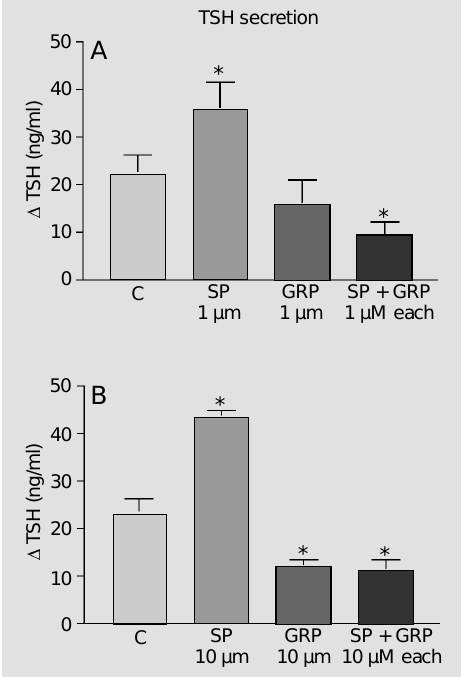
Figure 1 - Thyrotropin (TSH) re- lease from hemipituitaries incu- bated in the presence of medi- um alone (control, C) or 1 µM (Panel A) or 10 µM (Panel B) gas- trin-releasing peptide (GRP), substance P (SP) or both. D = Difference in medium TSH be- fore and after peptide addition. Data are reported as means ± SEM for 3